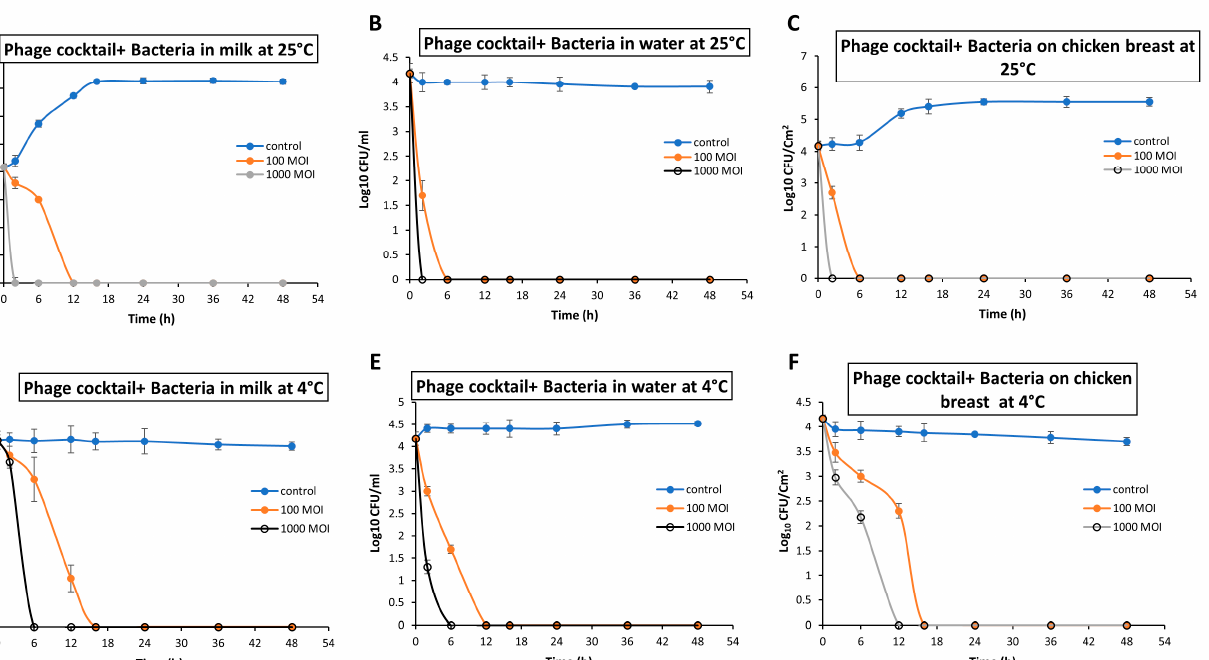
Figure 6. Stability of Salmonella phage cocktail in different food articles. ( A ) Stability in milk, ( B ) stability in water, and ( C ) stability on chicken breast. Phage cocktail titer of 8.3 log 10 PFU/mL was mixed with each food sample and incubated at either 4 °C or 25 °C for 48 h. The values represent mean with a standard deviation of three replicates of each time point.